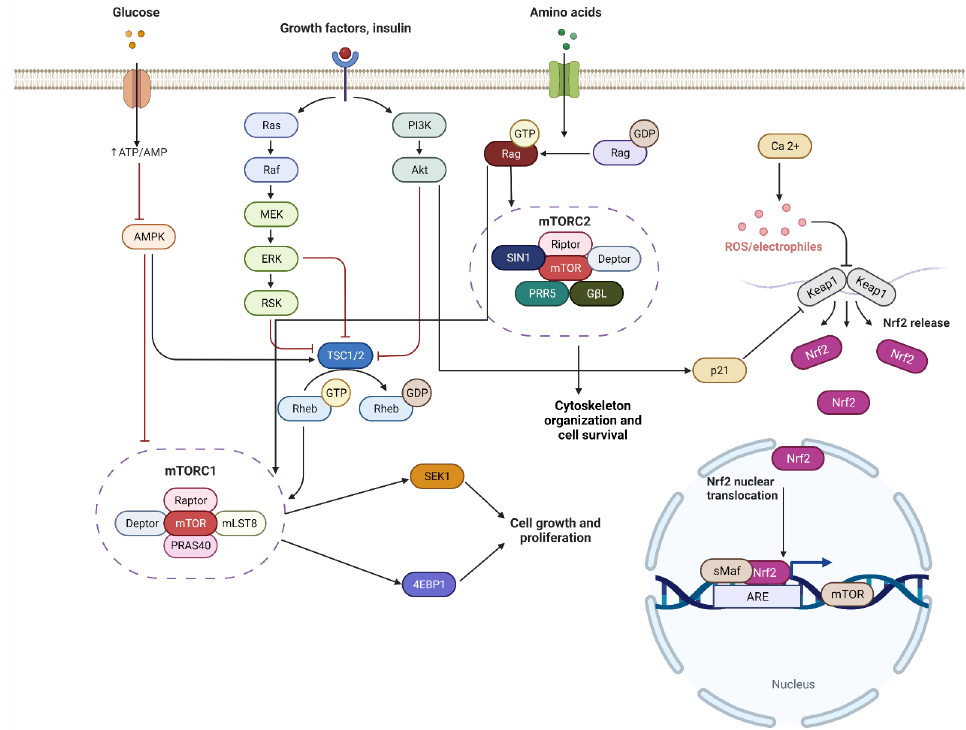
Figure 3. Nrf2 and mTOR mechanism pathway. AKT is one of the procedures of mTOR activity, which plays an important role in cellular mechanisms such as cell proliferation, cell cycle, and acti- vated p21, which then inhibits Keap1, which alternates the Nrf2 mechanism. The figure was pre- pared by software provided by Biorender.com (accessed 3 March 2022).